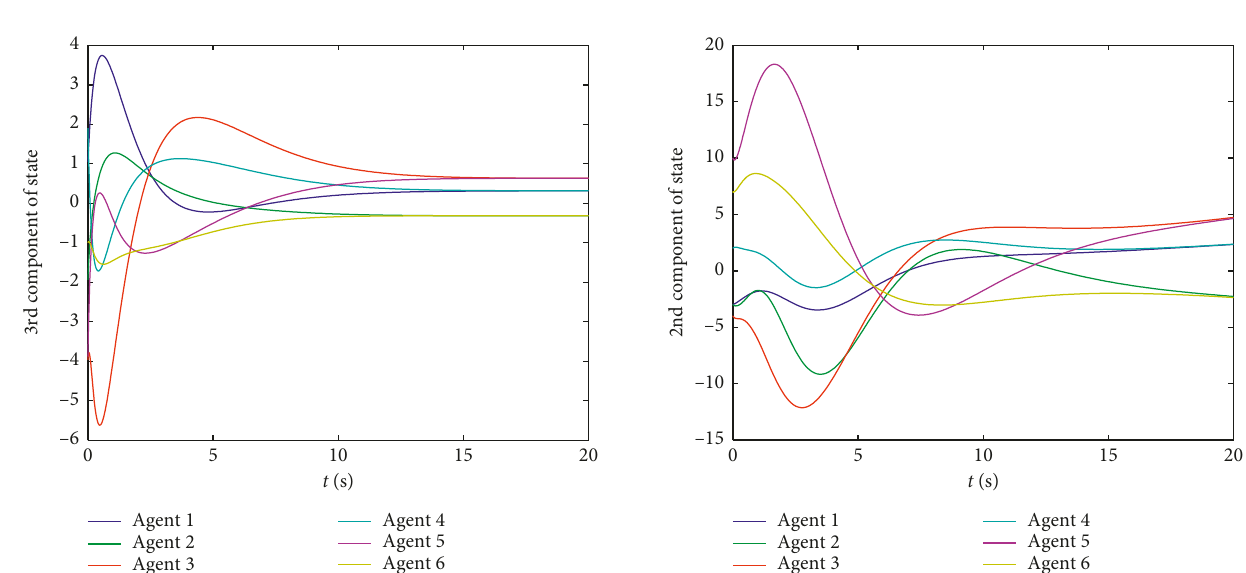
i, 1 via protocol (17).